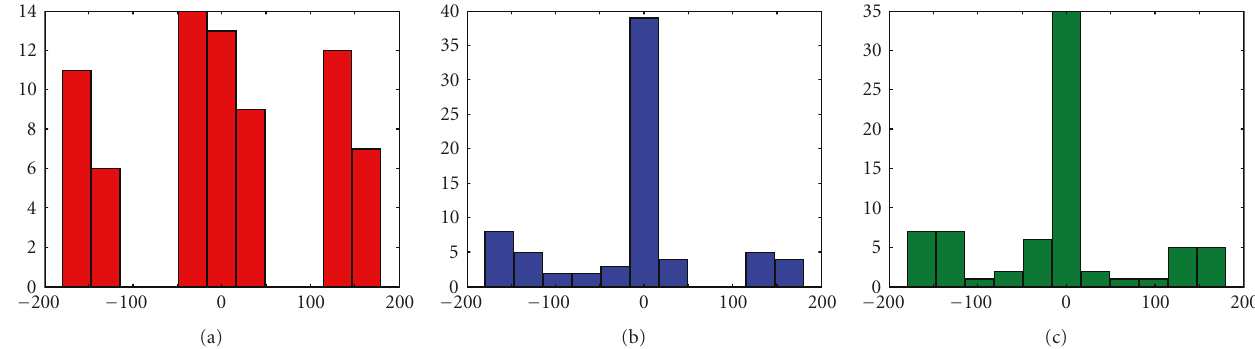
Figure 8: Histograms of the pose estimation error in degrees of one representative example from the COIL-20 database (40% occlusion): (a) PCA 2, (b) PCA 15, (c) 2-dimensional S P